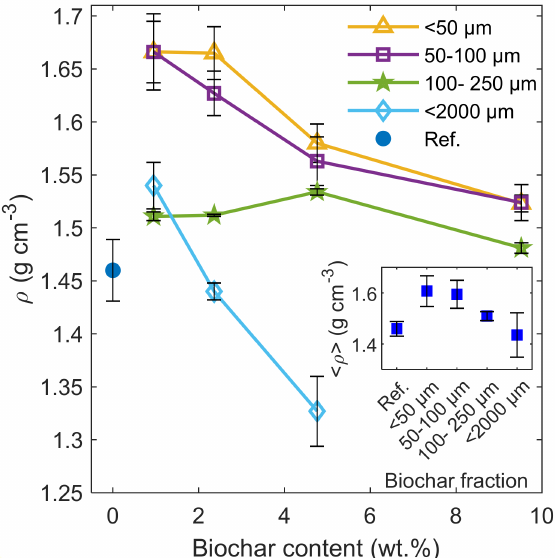
Figure 3. Bulk density ( ρ ) of the soil-biochar samples together with the standard deviation, compared to the reference value measured for the bare soil sample. The inset picture shows the dose-averaged bulk density ( < ρ > ) for the studied biochar